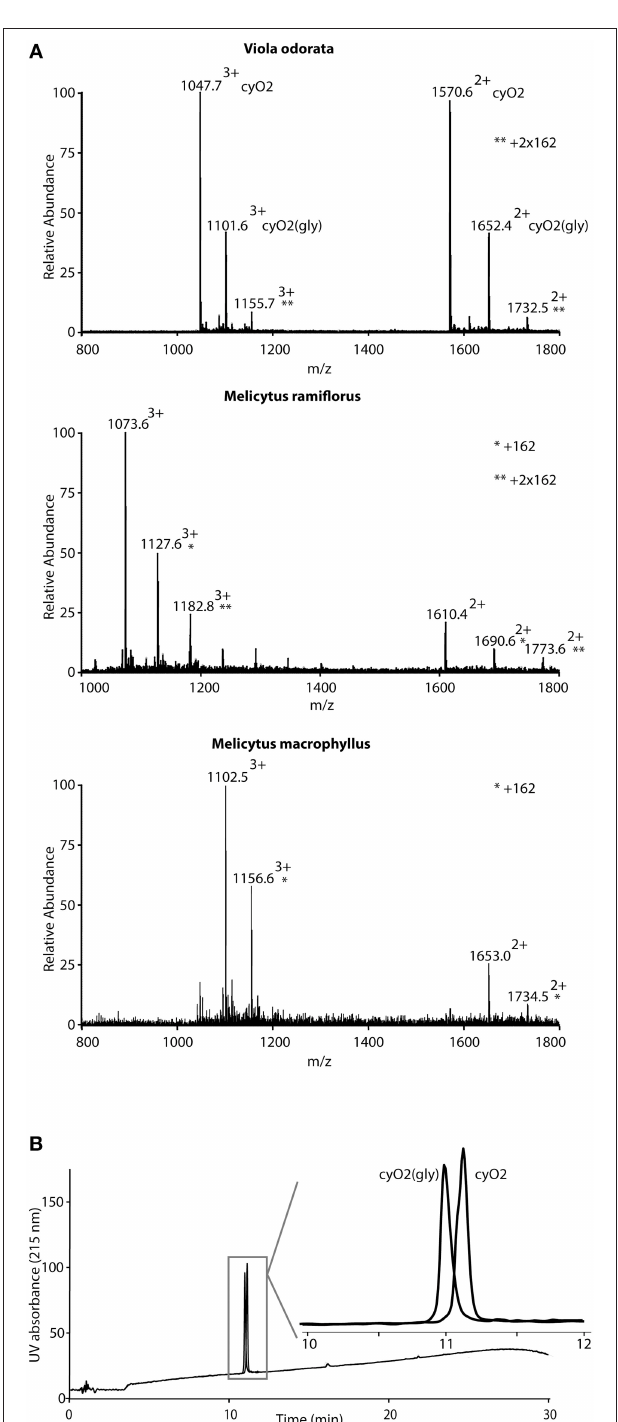
FIGURE 5 | Detection of glycosylated cyclotides. Cyclotides with additions of 162 mass units were observed for several of the cyclotides in the screening. (A) Shows representative MS-data for three cyclotides and their glycosylation products from three species. At the top, Viola odorata containing cycloviolacin O2 (cyO2) as demonstrated by the doubly and triply charged ions (1570.6 2 + /1047.7 3 + ) and the corresponding ions for cyO2(gly)